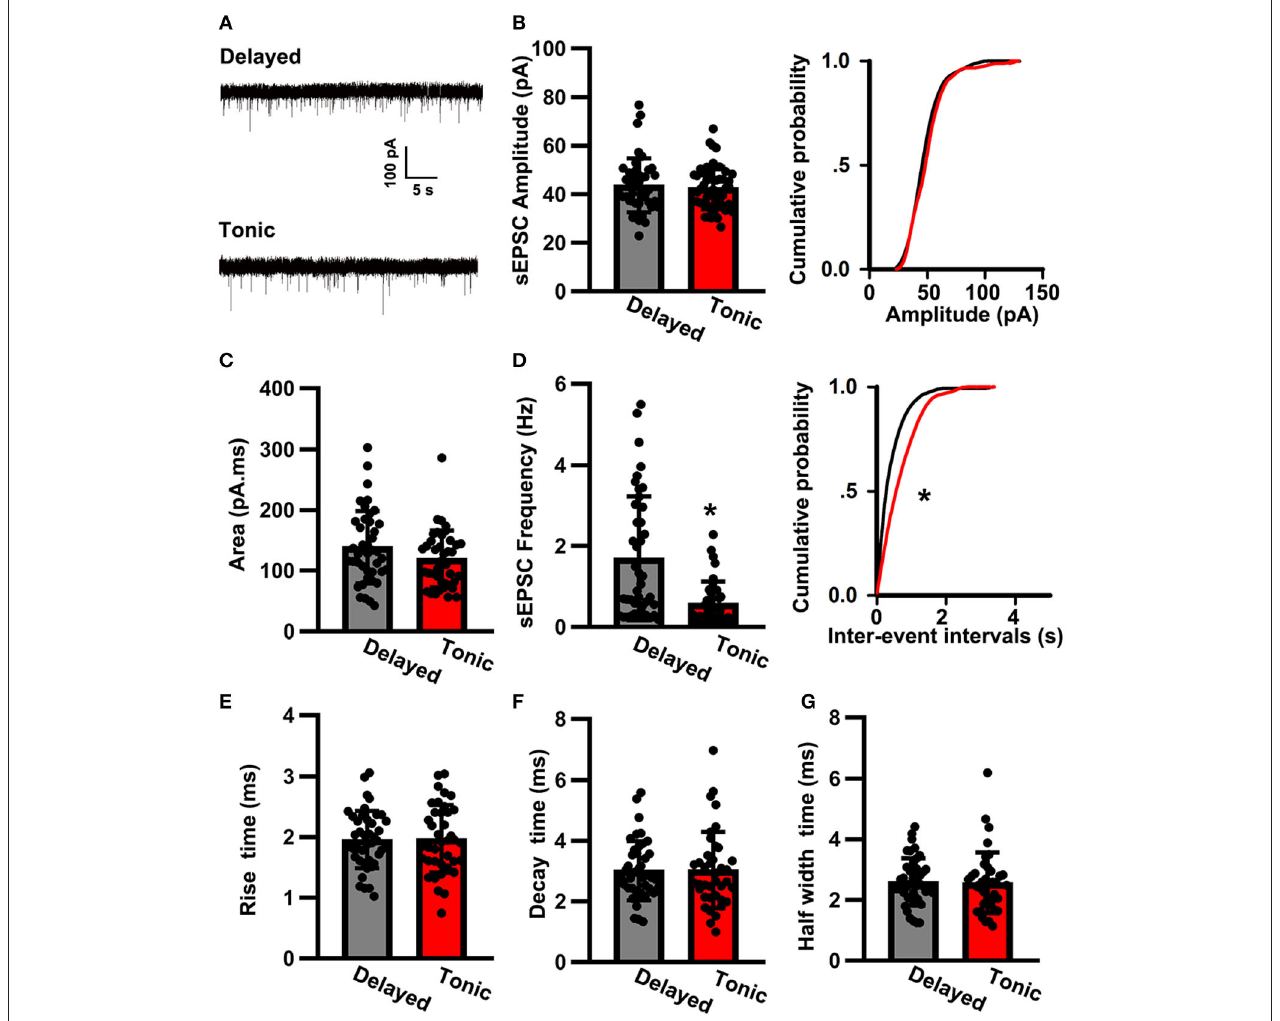
FIGURE 3 | The spontaneous excitatory postsynaptic current (sEPSC) properties of SG neurons. (A) Examples of sEPSC in two groups. The time scale bar is 5s and the amplitude bar is 100pA. Comparison of amplitude (B) , area (C) , frequency (D) , rise time (E) , decay time (F) , and half-width time (G) of sEPSC between delayed-firing pattern and tonic-firing pattern neurons. Data were shown as mean ± SEM. * p < 0.05.